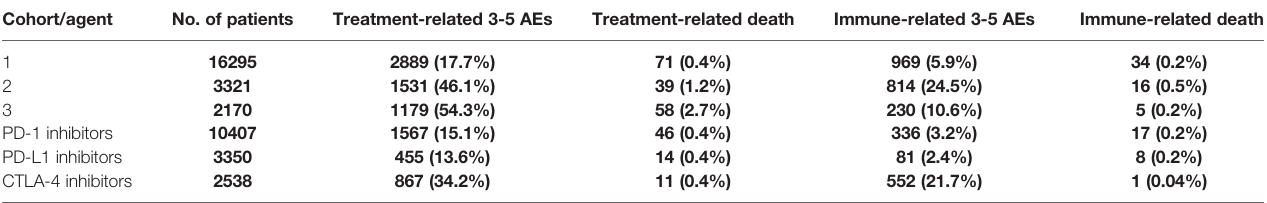
TABLE 1 | Overall incidence of grade ≥ 3 trAEs and